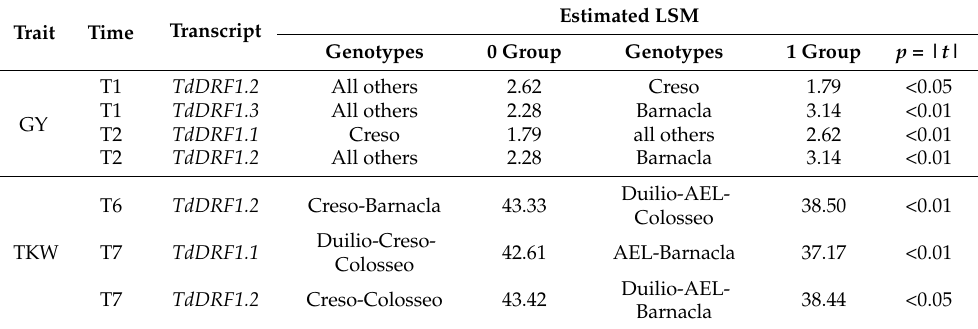
Table 5. Statistical association between molecular and agronomical data under RI condition. Molecu- lar data were represented as a binary code and agronomical traits are referred to as GY and TKW.